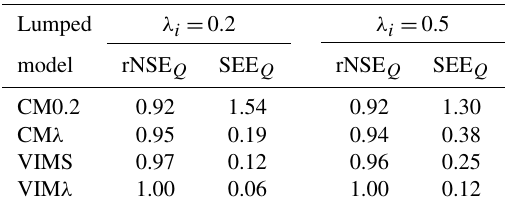
Table 4. Performance of the models for the cases of λ i = 0.2 and 0.5, when the degree of heterogeneity in the synthetic watershed (Table 2) was increased by doubling the values of S i for HRUs 3 and